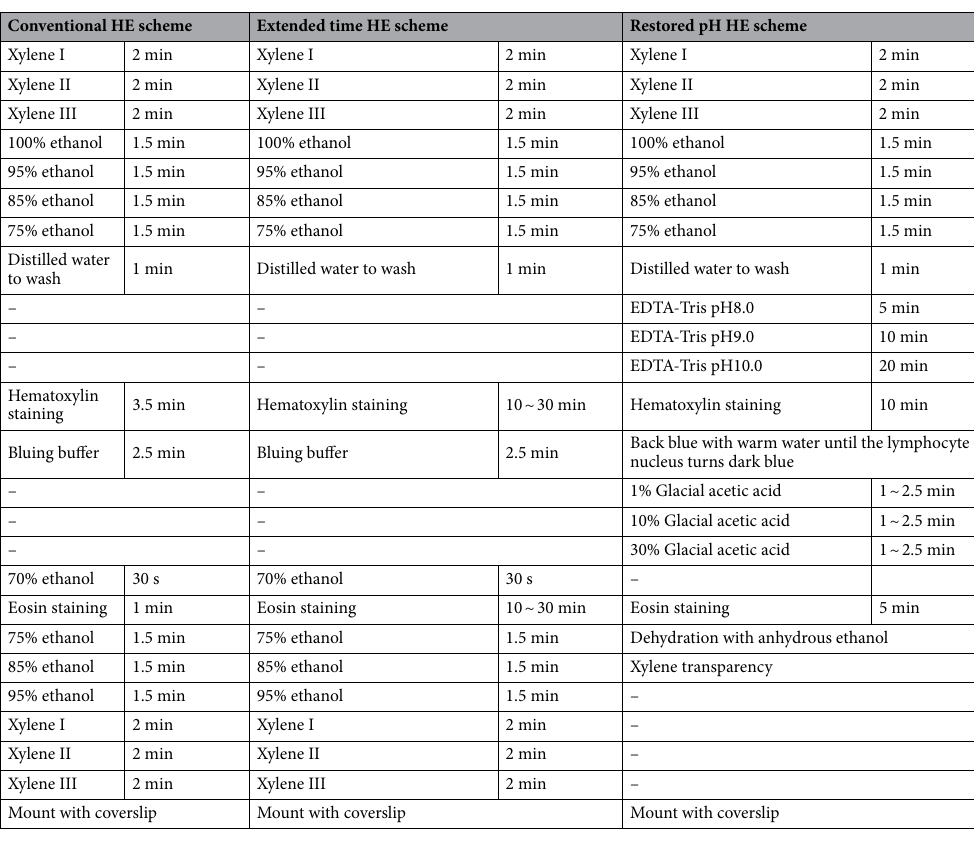
Table 1. Three HE staining methods.